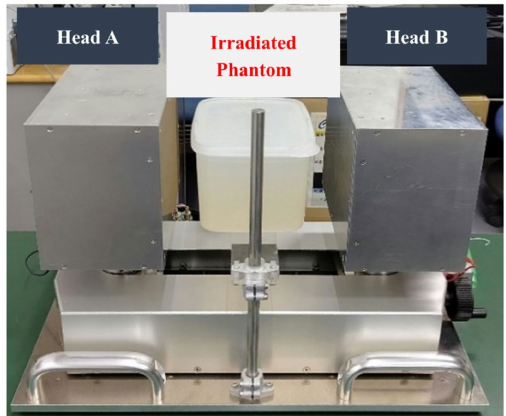
Figure 3. Experimental setup of scanning the irradiated water-gel phantom using a dual-head PEMGRAPH